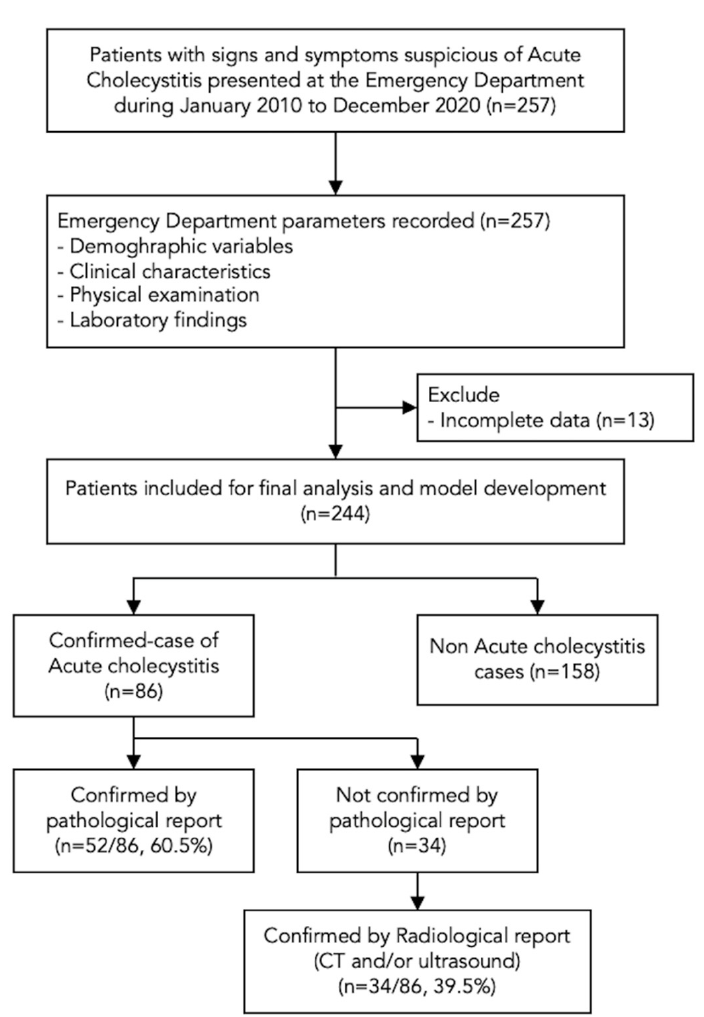
Figure 1. Study Figure 1. Study flowchart.